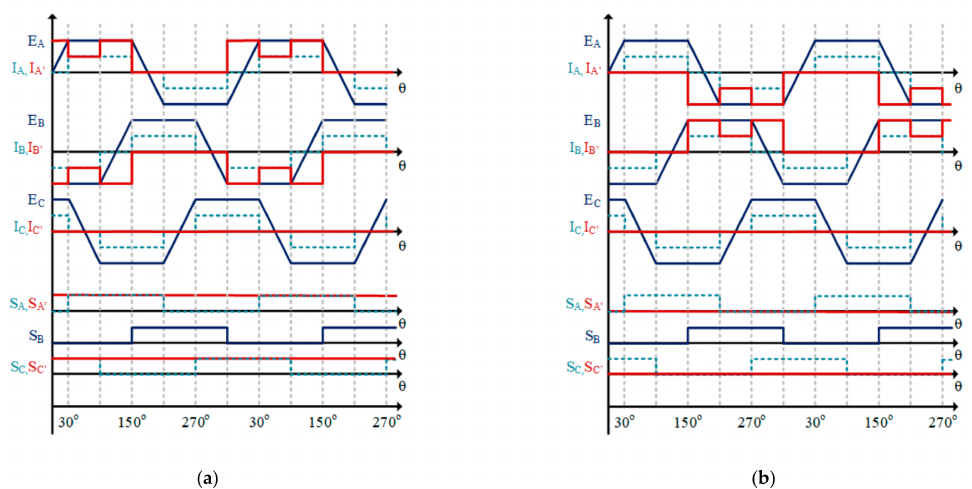
Figure 12. Comparison of ideal and resulting phase current waveforms according to the defective configuration. ( a ) Defective sensors A and C at high state; ( b ) Defective sensors A and C at low